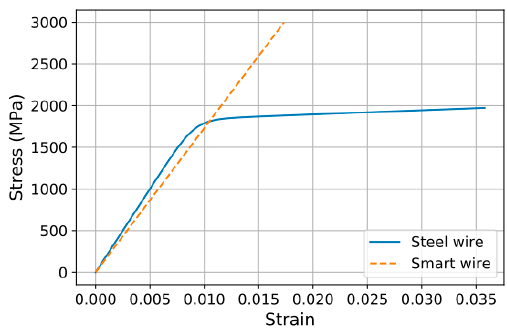
Figure 6. Material models for steel wire and CFRP wire.